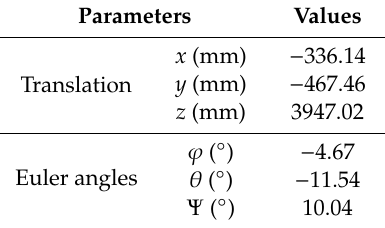
Table 4. Parameters of the three-dimensional (3D) solid–rigid transformation to align the data.